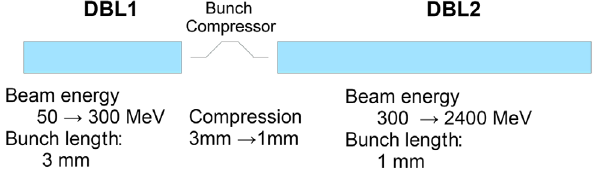
FIG. 6. Compressor chicane position in the drive beam linac [4].